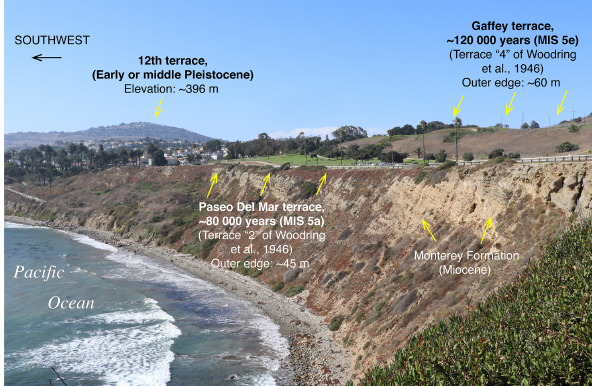
Figure 27. View of outer edges of the Paseo del Mar ( ∼ 80ka) and Gaffey ( ∼ 120ka) terraces, looking northwest from Point Fermin (see Fig. 26). On left side of photograph, a small fragment of the 12th terrace is visible ( = LACMIP loc. 1304 in Fig. 26). Photograph by Daniel R.